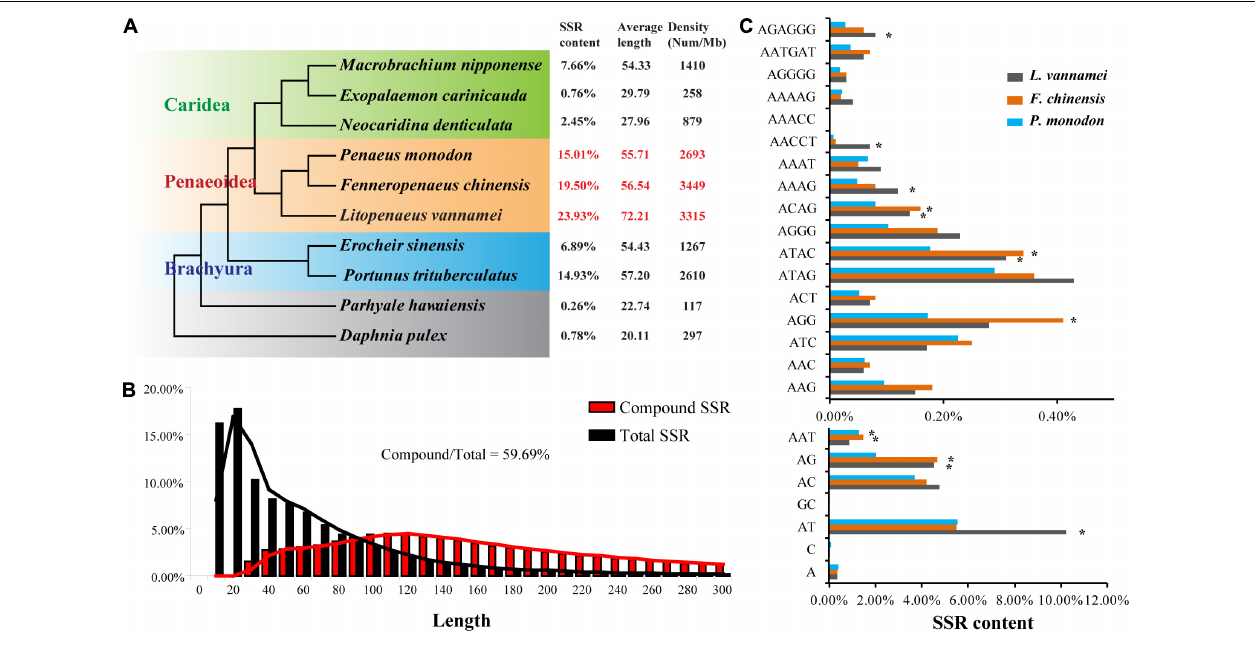
FIGURE 4 | Simple sequence repeats (SSRs) in penaeid shrimp genomes. (A) Content, average length, and density of SSRs in the genomes of various crustaceans. The phylogenetic tree was referred from a previous study (Yuan et al., 2018). The characteristics of SSRs in various crustaceans were referred from the study of Yuan et al. (2021). Since the SSR content may be underestimated in the Marsupenaeus japonicus genome, it was not shown and compared with the other three shrimp genomes. (B) The length distribution of compound SSRs and total SSR in the Litopenaeus vannamei genome. The compound SSR indicates numerous different types of SSRs connected head to tail. (C) Comparisons of the distributions of various types of SSRs in three penaeid shrimp genomes. A part of SSR types with relatively high content in the genome was shown in the plot. TABLE 2 | Statistics of genome assembly of Litopenaeus vannamei using different methods. SOAPdenovo § FALCON HABOT2 DBG2OLC SMARTdenovo WTDBG2